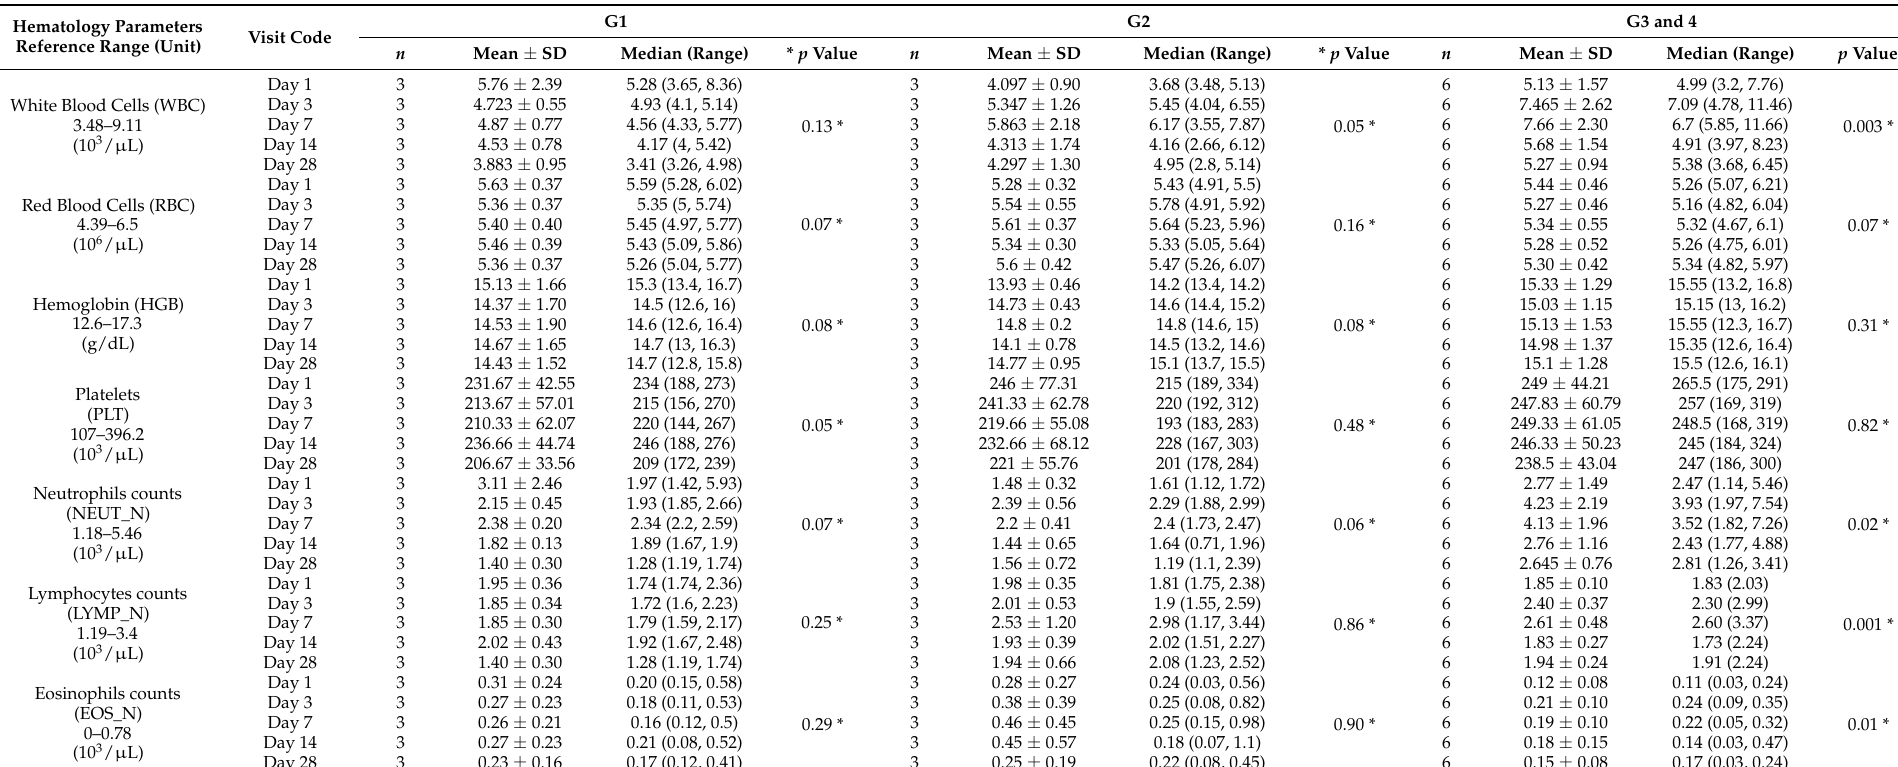
Table 4. Results of the hematology test for the first 28 days of administration of M. senegalensis in study groups 1, 2, 3 and